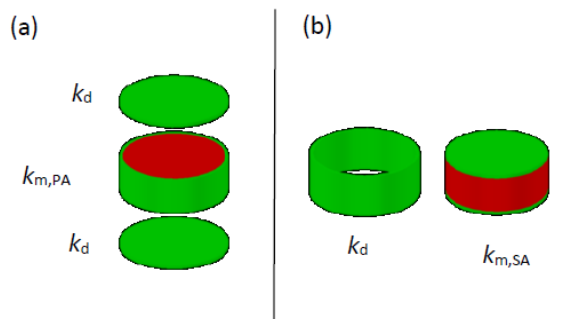
Figure 1. Approaches for permeation in heterogeneous media: ( a ) considered in Reference [1]; ( b ) suggested in this Comment.